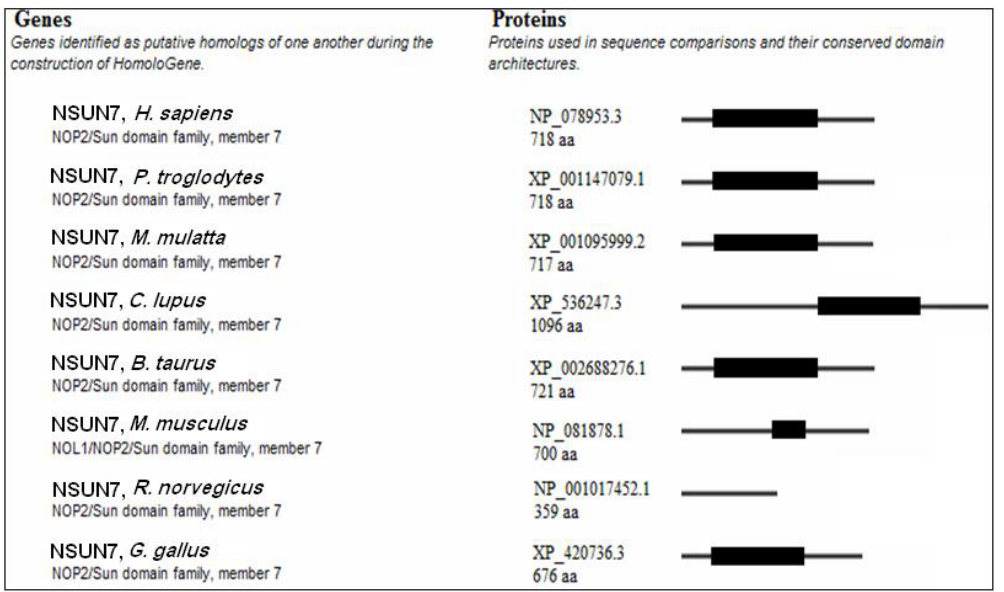
Fig. 2. Conserved domain in some of Homologous of the Nsun7 gene: NP_ and XP_ are protein ID number and the digits after the point, are